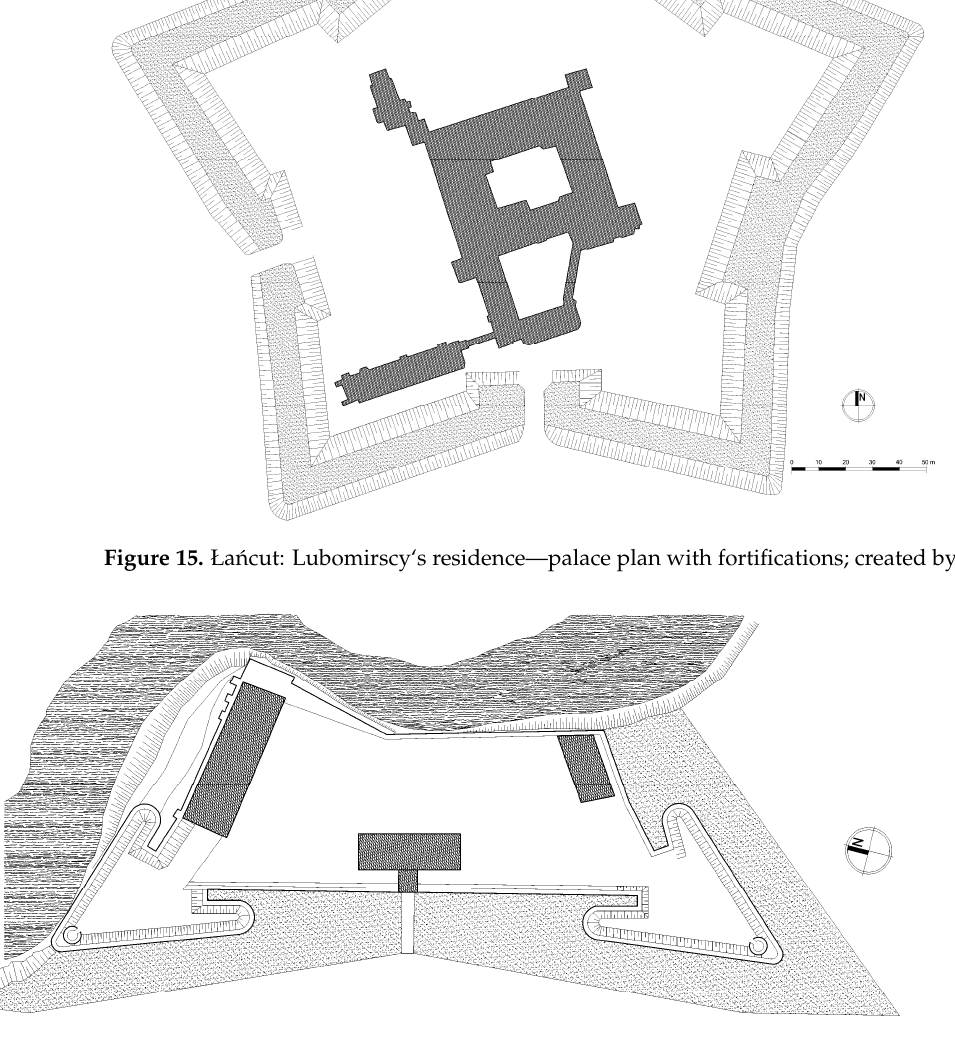
Figure 16 . Dubno: Lubomirscy’s residence—palace plan with fortifications; created by authors. The arcades built around the inner courtyard are the second innovative element of Pr ó szk ó w castle. The conversion of the castle to a baroque style between 1677 and 1686 makes the reconstruction of the Renaissance decorations on the longer (south and north) elevations difficult. The only exception is the ground floor, where the plan of the arcades was identified during the research work. On the west elevation, there was a logia, which consisted of three arcades and which was supported by marble columns, semicolumns, and masonry pillars (Figure 20a). A similar solution might have been adopted to the non-retained parts of the castle. Therefore, the castle could be considered as a complex with a form and detail that were equal to Duke Jerzy II’s residence in Brzeg from the years 1544–1560. In